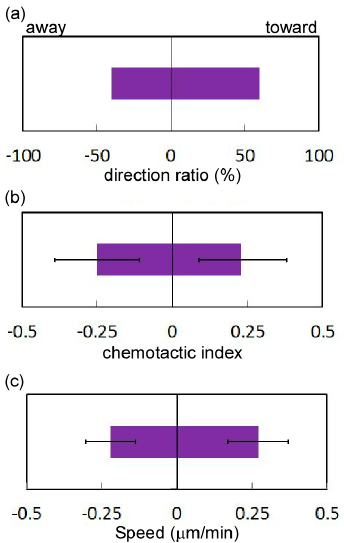
Figure 18. Analysis of the chemotaxis of HeLa cells. ( a ) Direction ratio; ( b ) Chemotactic index; ( c ) Migration speed toward and away from the high-concentration region.